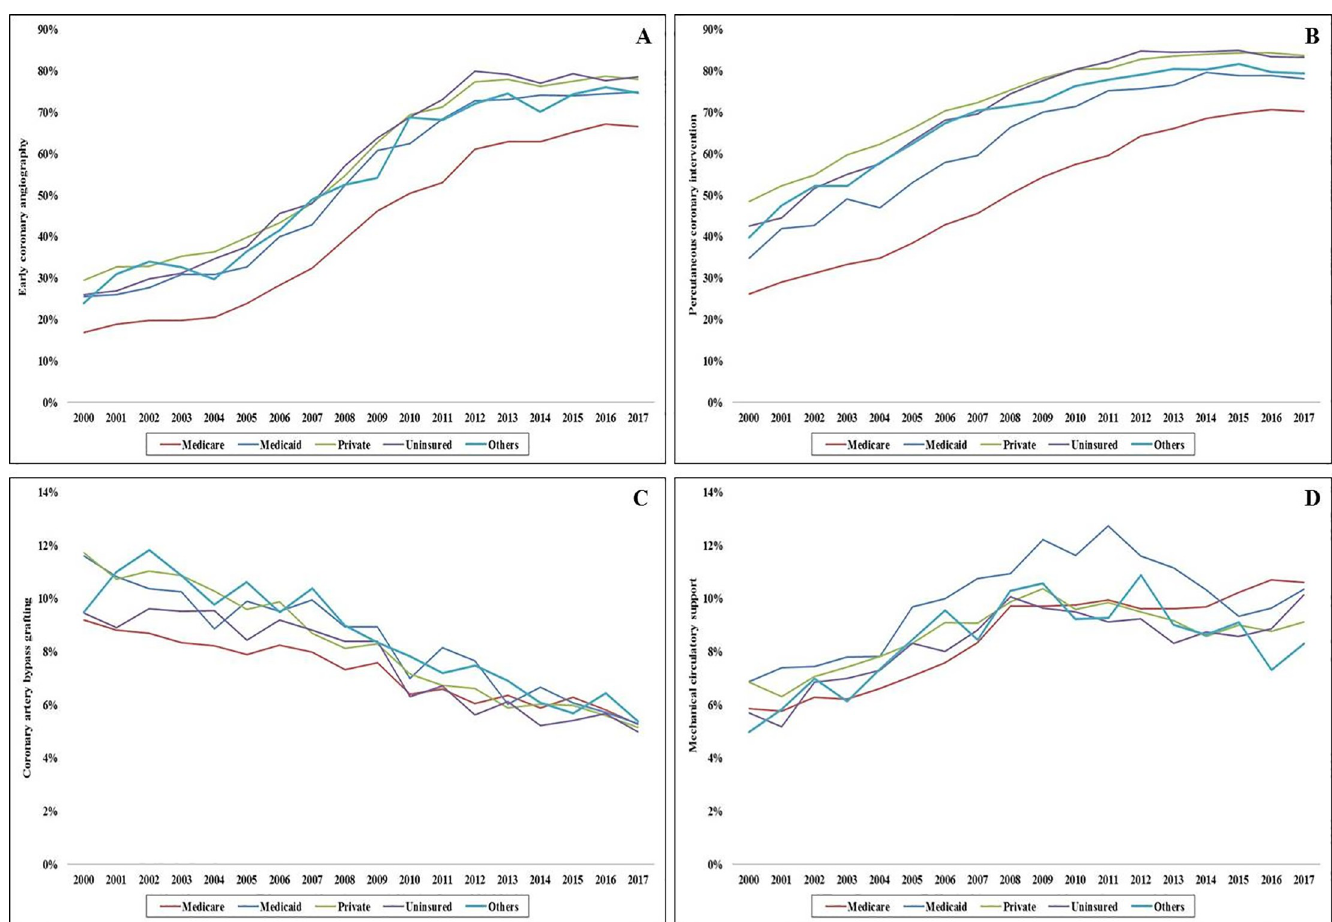
Fig 2. Temporal trends in cardiac procedures use in STEMI admissions stratified by insurance status. Eighteen-year trends of early coronary angiography ( A ), percutaneous coronary intervention ( B ), coronary artery bypass grafting ( C ), and mechanical circulatory support ( D ) in STEMI admissions stratified by insurance status; all p < 0.001 for